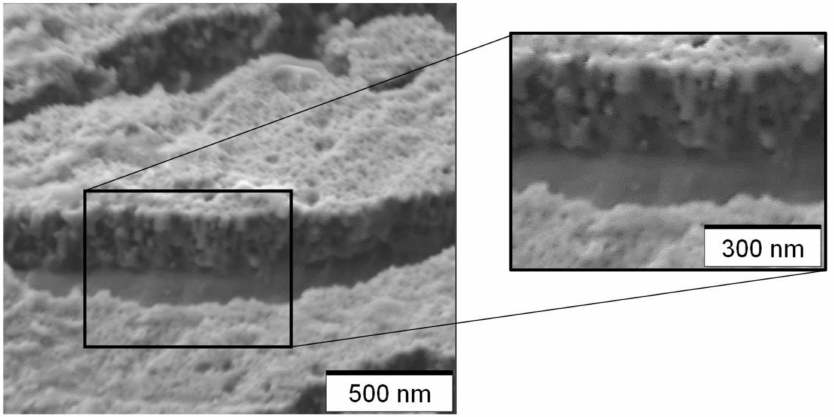
Figure 11. Secondary electron image of the fractured oxide in close proximity to the fracture edge under a tilt angle of approximately 60 ◦